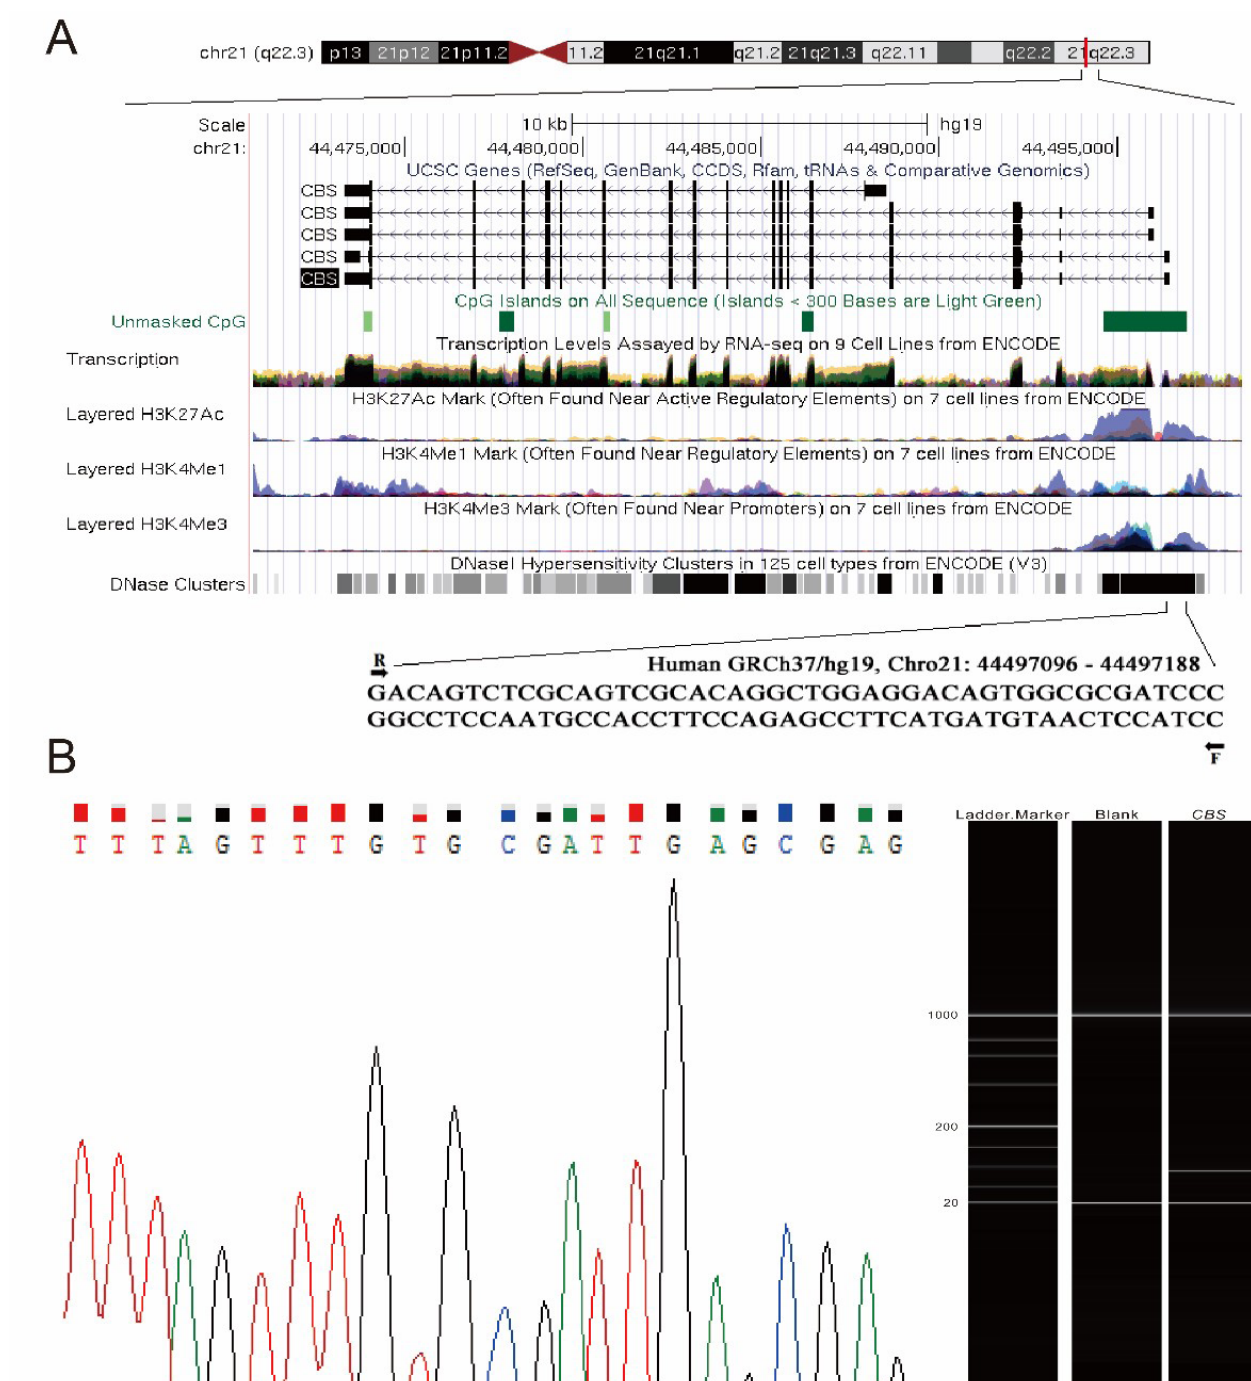
Figure 1 - Methylation assay of the CBS gene and its quality control. (A) The abridged general view of five CpG sites on the CBS gene promoter. F: forward primer; R: reverse primer. The genomic positions and functional annotations of CBS were obtained from the UCSC genome browser according to human 2013 (GRCh37/hg19). (B) Methylation status of the CBS gene in patients with hypertension was analyzed by quantitative methylation-specific